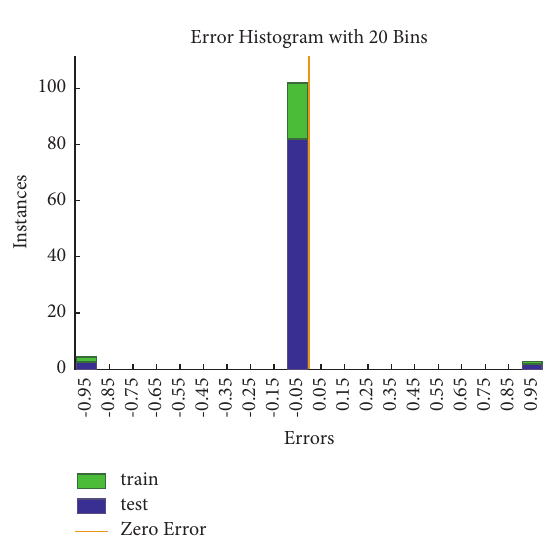
Figure 11: Histogram of the error distribution of the training and test